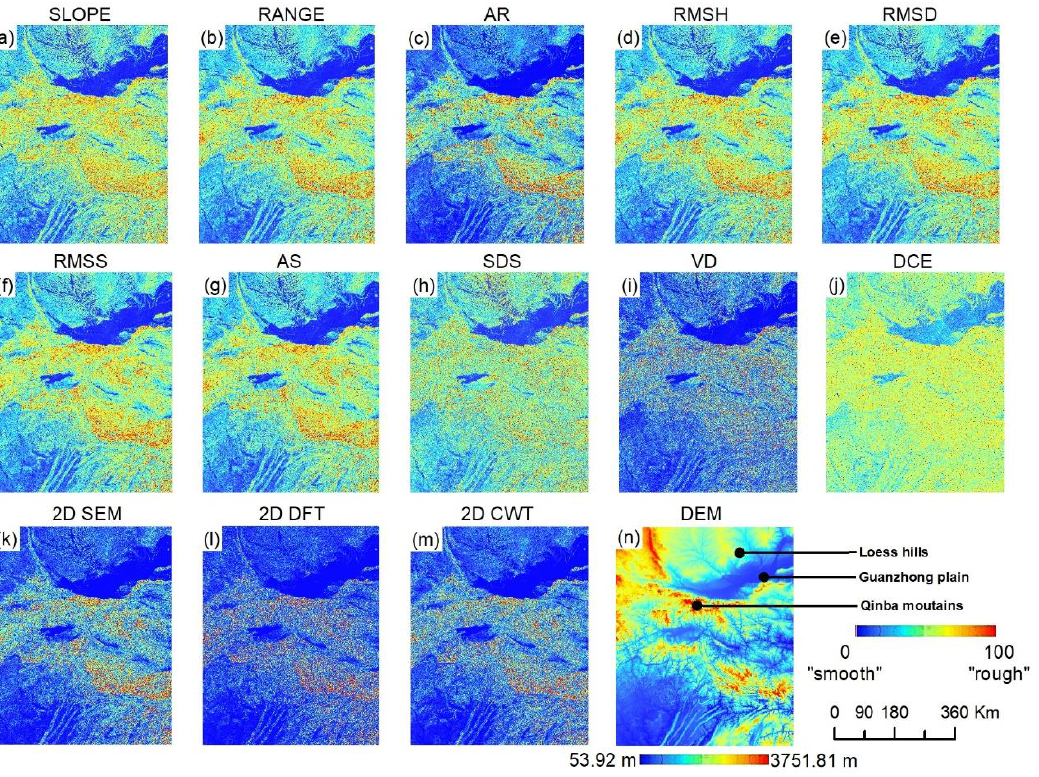
Figure 3. Extraction results of the different roughness algorithms: ( a ) SLOPE; ( b ) RANGE; ( c ) AR; ( d ) RMSH; ( e ) RMSD; ( f ) RMSS; ( g ) AS; ( h ) SDS; ( i ) VD; ( j ) DCE; ( k ) 2D SEM; ( l ) 2D DFT; ( m ) 2D CWT; ( n ) original SRTM.